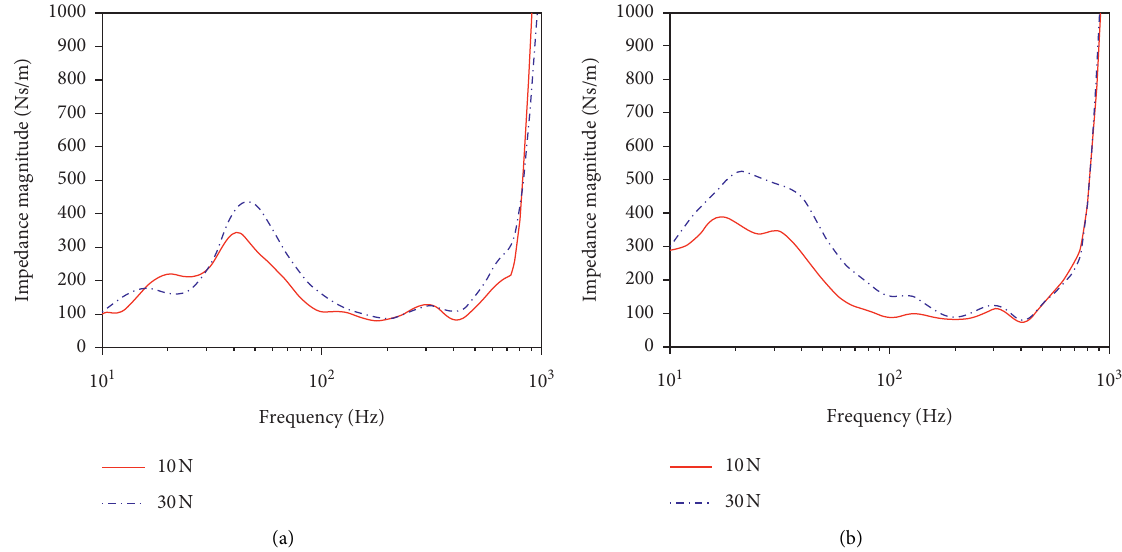
Figure 10: Amplitude of mechanical impedance of the hand-arm system under different push forces (5m/s 2 vibration magnitude and 30N grip force). (a) 90 ° elbow angle. (b) 180 ° elbow angle.